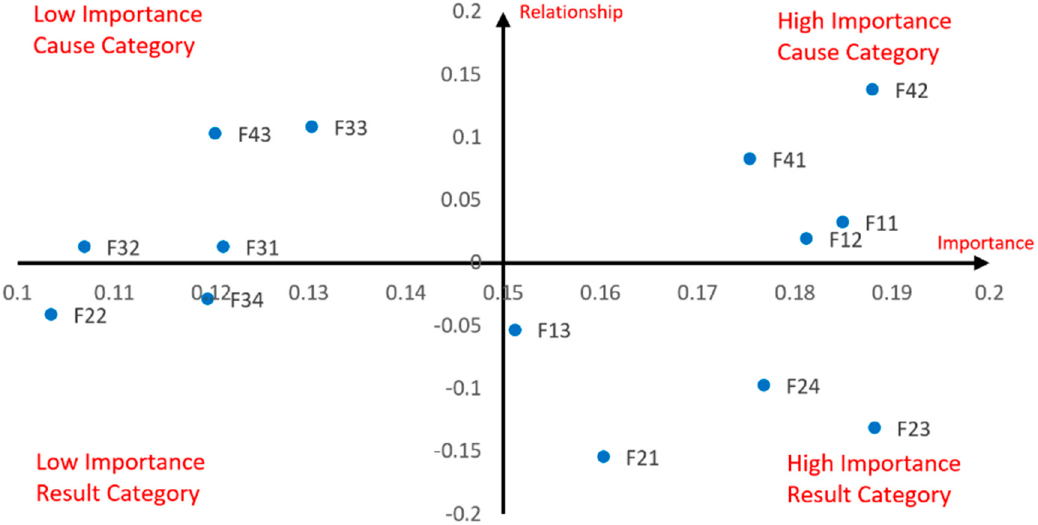
Figure 5. The importance–causality diagram.